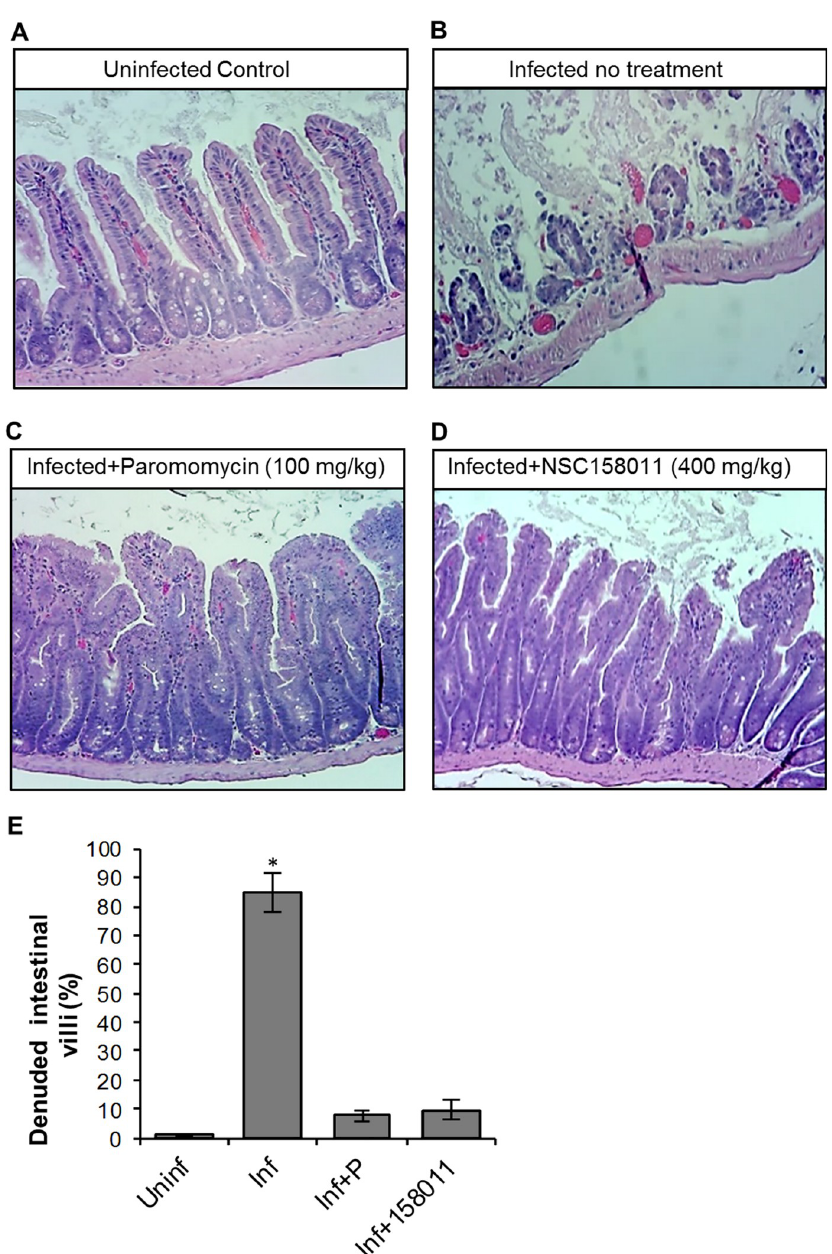
Fig 7. Histopathological analysis of the effect of Cryptosporidium parvum infection in the lower small intestines of mice with or without NSC158011 treatment. Mice infected with C . parvum were maintained untreated (Infected no treatment), treated with paromocycin (Infected+Paromomycin (100 mg/kg)) or treated with compound NSC158011 at 400 mg/kg (Infected+NSC158011 (400 mg/kg)) for 8 days. Uninfected mice were maintained as control (Uninfected Control). After 8 days, mice were sacrificed and the lower intestinal tissue processed for histology and stained with hematoxylin and eosin. (A) Uninfected control mice samples depicted intact intestinal epithelium with prominent villi. (B) In contrast, infected mice without treatment depicted denuded villi. Both (C) paromomycin and (D) NSC158011 treated infected mice depicted intact intestinal epithelium with prominent villi that were comparable to the uninfected control. The images are representative of samples analyzed from 3 mice per treatment group. (E) The mean percentage of denuded intestinal villi in 4 randomly chosen microscopic fields per sample from the uninfected (Uninf), infected untreated (Inf), Infected treated with paromomycin (Inf+P), and infected treated with 400 mg/kg NSC150811 (Inf+150811) mice. The data shown represent means for samples from three mice per group with standard error bars and levels of statistical significance depicted ( � P <